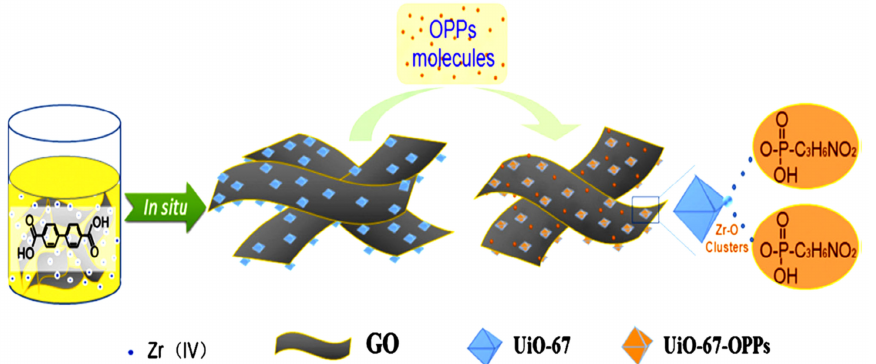
Figure 16. Synthesis of UiO-67-GO and adsorption of glyphosate molecules. Reprinted with permis- sion from